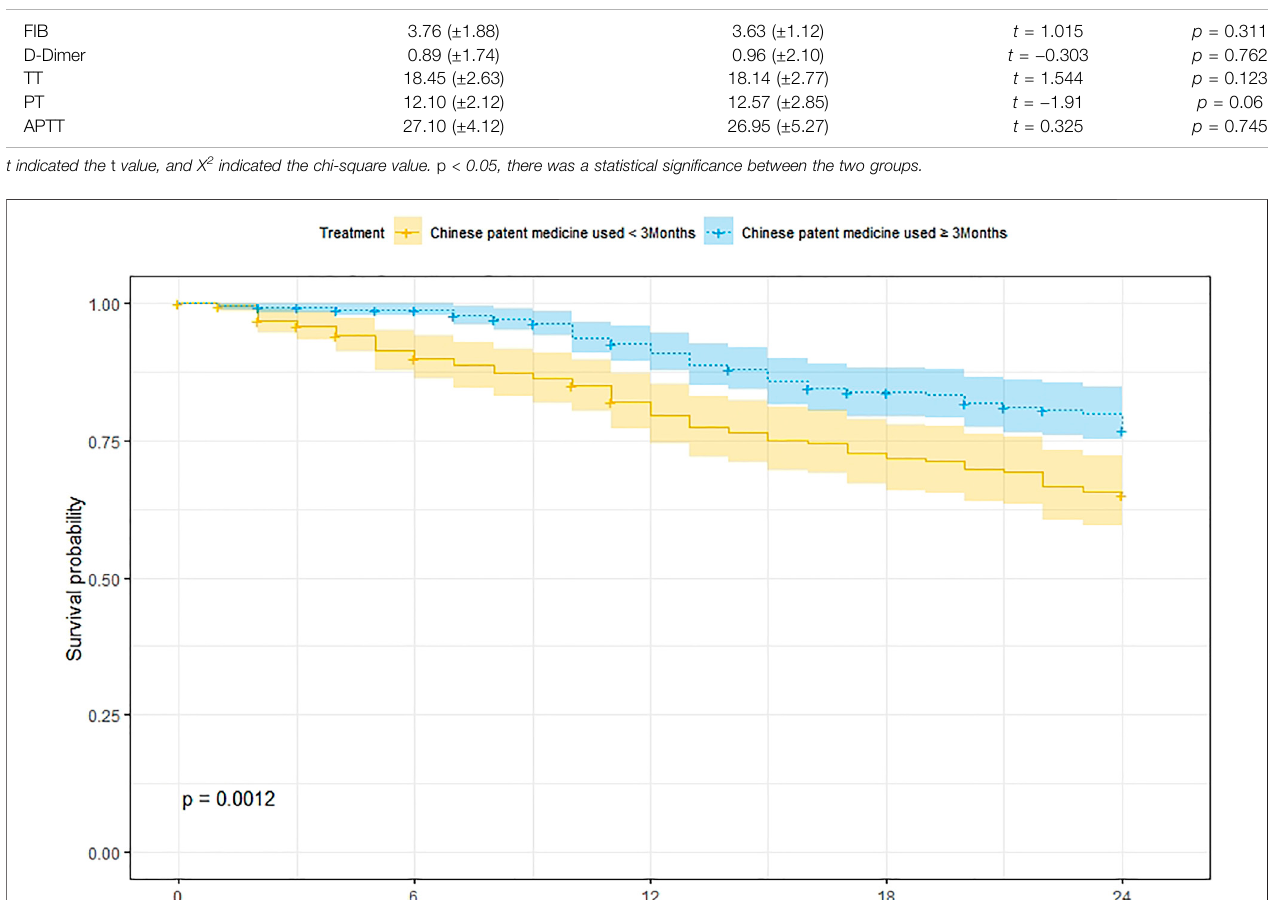
Frontiers in Pharmacology |